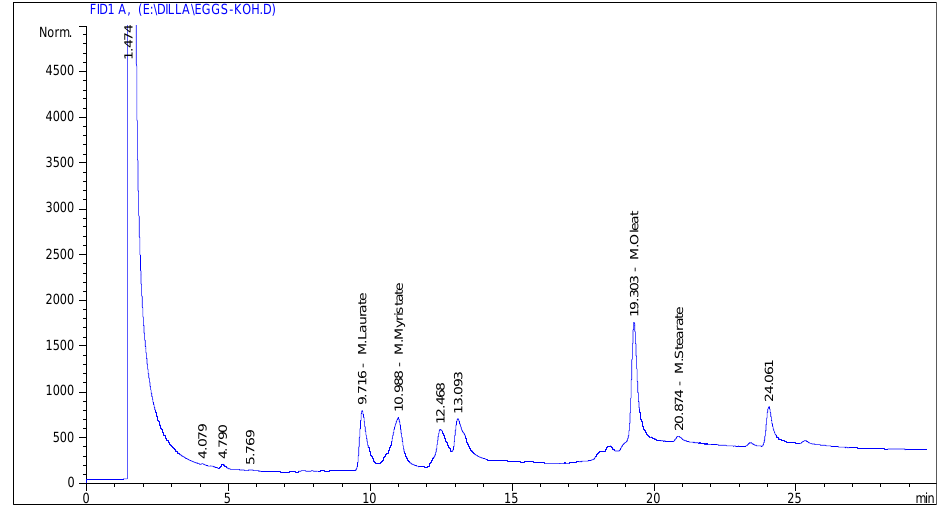
Figure 8. Chromatogram of biodiesel yield from transesterification of the KOH-impregnated